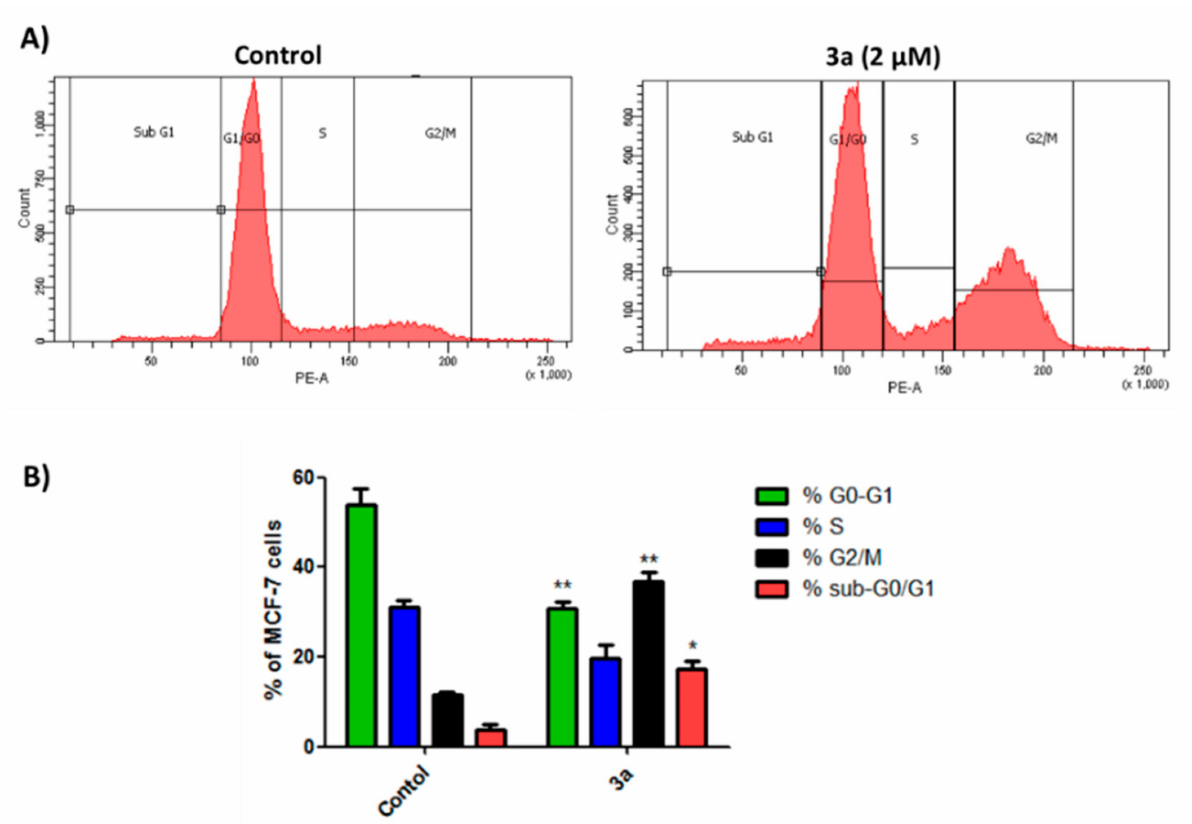
Figure 4. ( A ) Effect of compound 3a on the cell cycle and apoptosis in breast cancer MCF-7 cells. The cells were treated with either a vehicle (0.1% ethanol ( v / v )) or 3a (2 µ M) for 48 h. The cell cycle analysis was performed on histograms of gated counts per DNA area (FL2-A). ( B ) Quantitative analysis of 4N (G2/M), 2N (G0G1), >2N (S) and <2N (sub-G1). The DNA content was determined with CellQuest software. The values represent the mean ± SEM for three independent